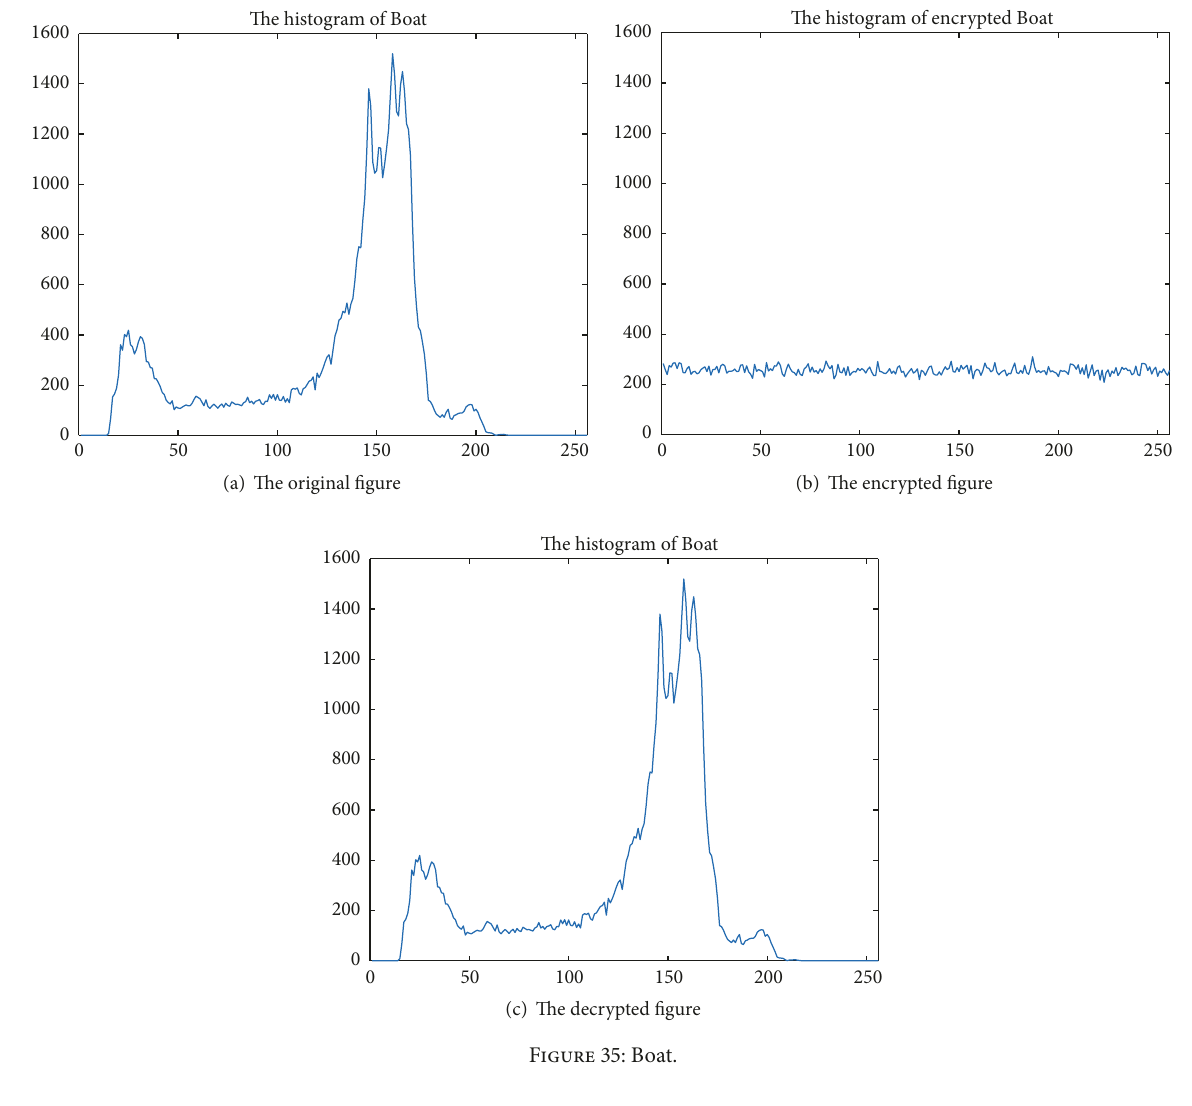
Table 15: NPCR and UACI between cipher-images with slightly different plain-images.